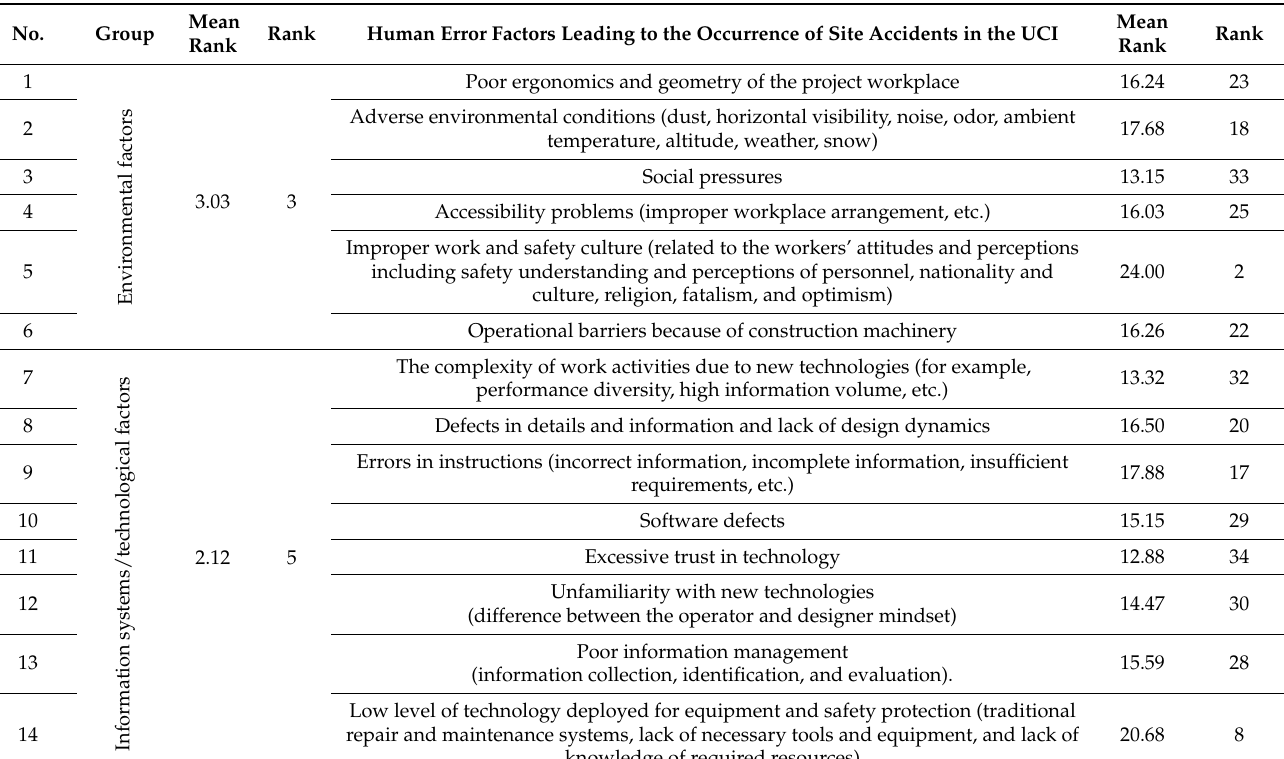
Table 6. Results of Friedman test (mean ranking of groups/factors affecting human errors in the